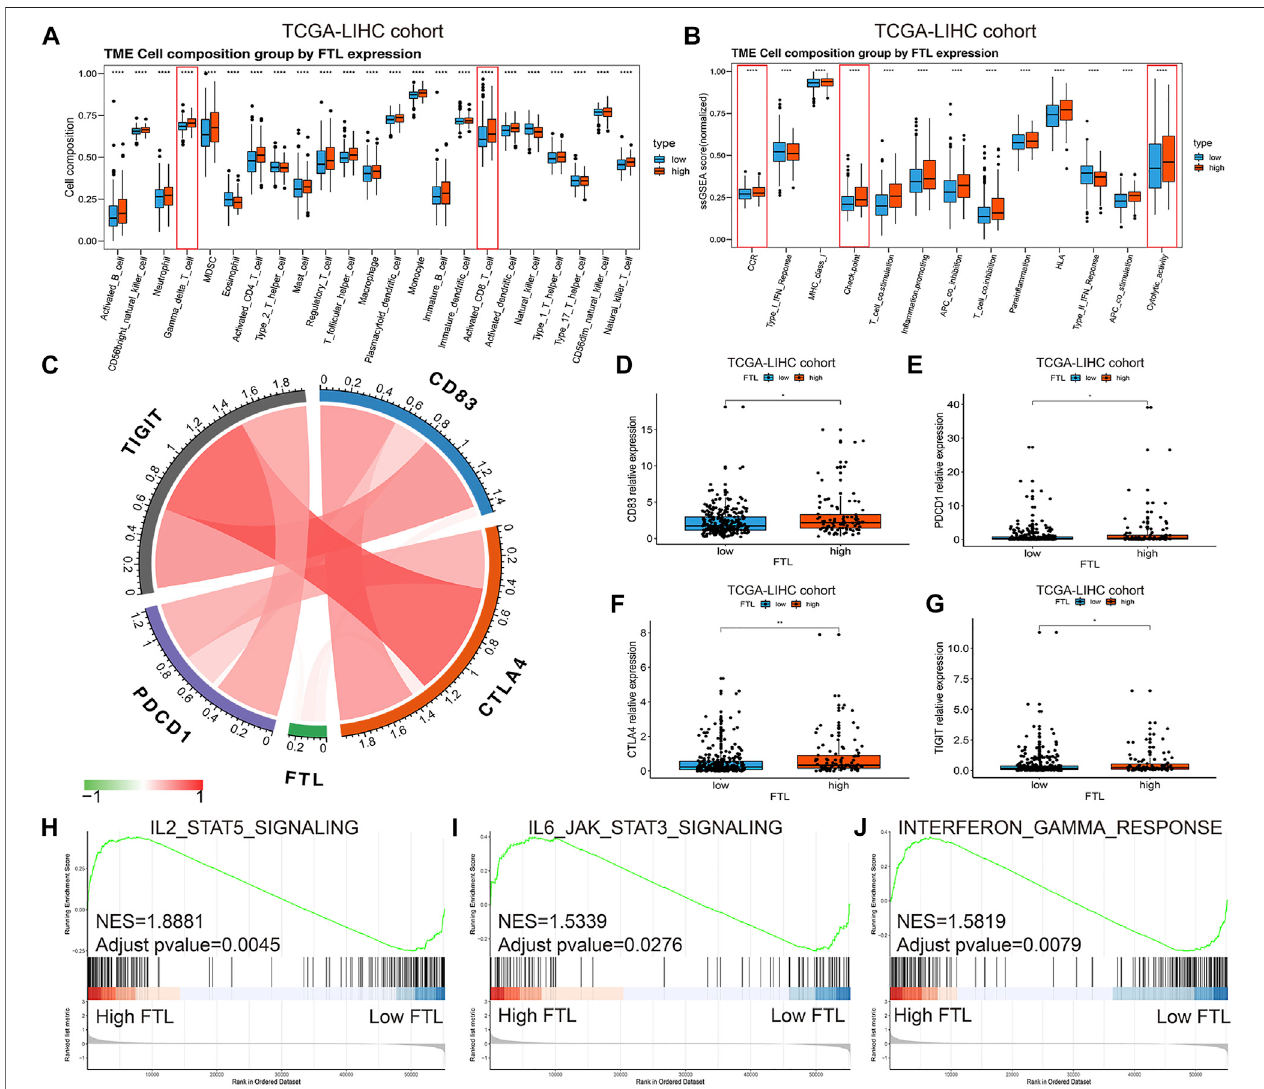
FIGURE5| Identi fi cationofimmunecellin fi ltrationandimmuneactivitybetweenhighFTLandlowFTLHCCpatients. (A) Boxplotshowingimmunecellin fi ltrationin HCCpatientsinthehighFTLgroupcomparedwiththelowFTLgroup. (B)